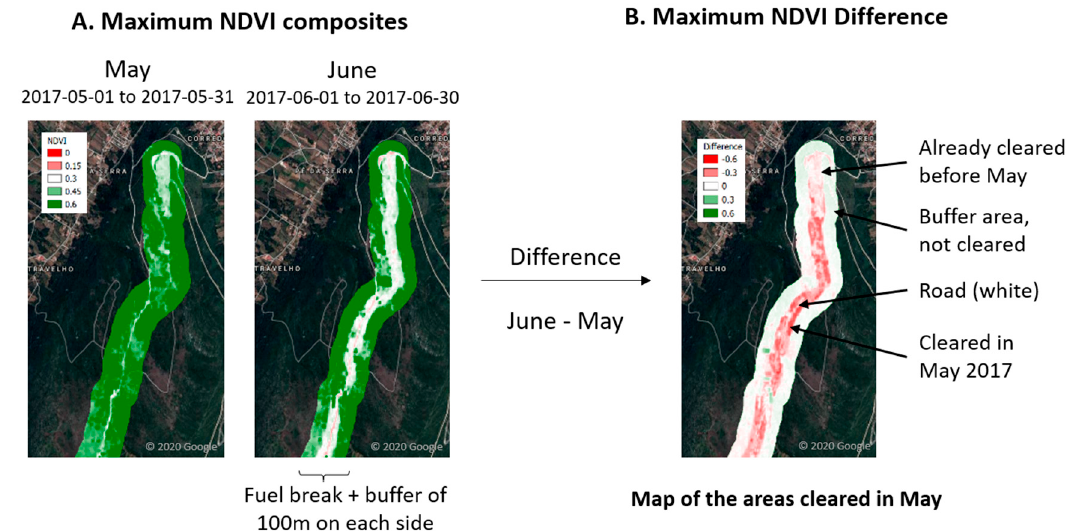
Figure 5. Example in Serra de Candeeiros (shrubs) of: ( A ) two monthly maximum NDVI composites; ( B ) their difference (June composite–May composite).Training datasets were established using the information provided by ICNF on the location of fuel treatments, and also through visual image interpretation. The training dataset contains the values of 20,000 points inside and outside the FB, from all months of the year, one-third of which correspond to locations where fuel removal interventions occurred.